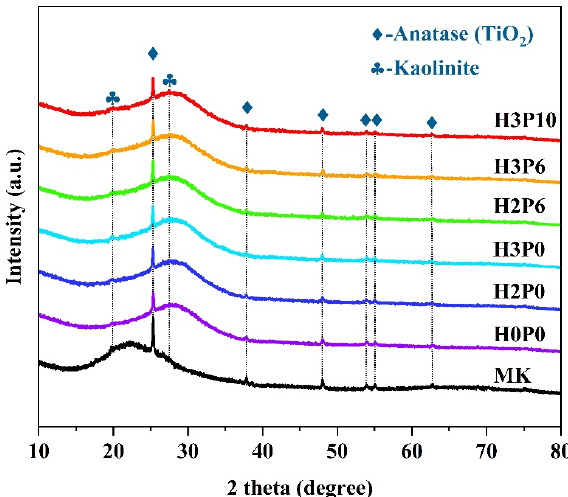
Figure 5. XRD patterns of matrix and geopolymer foams with different H 2 O 2 and palm olein content.